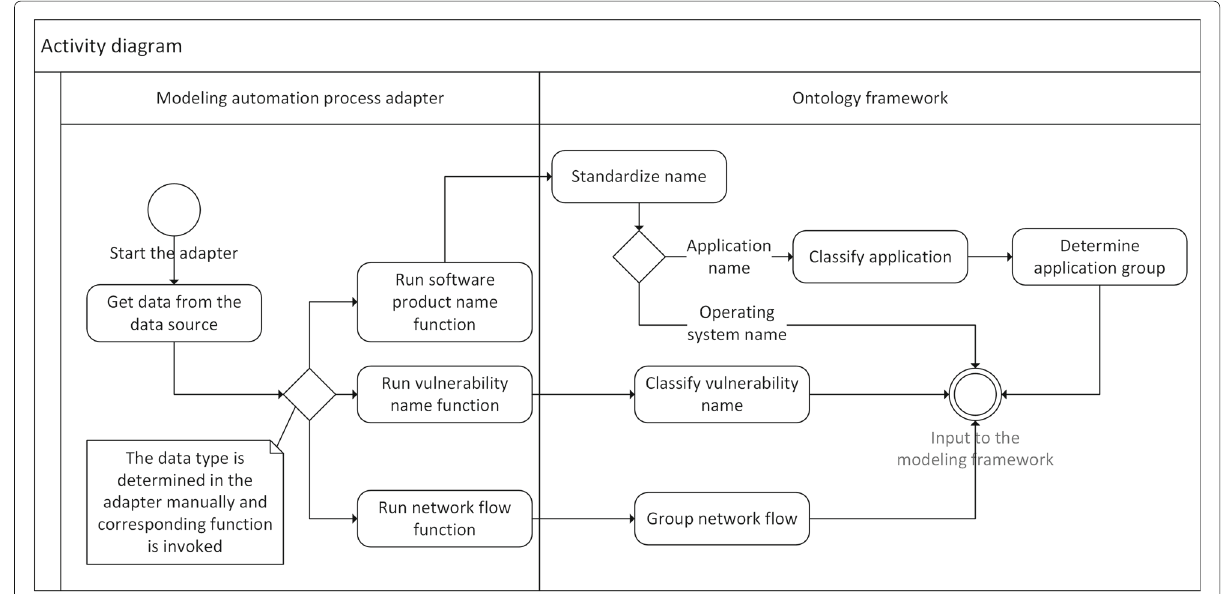
Fig. 10 Implementation activity